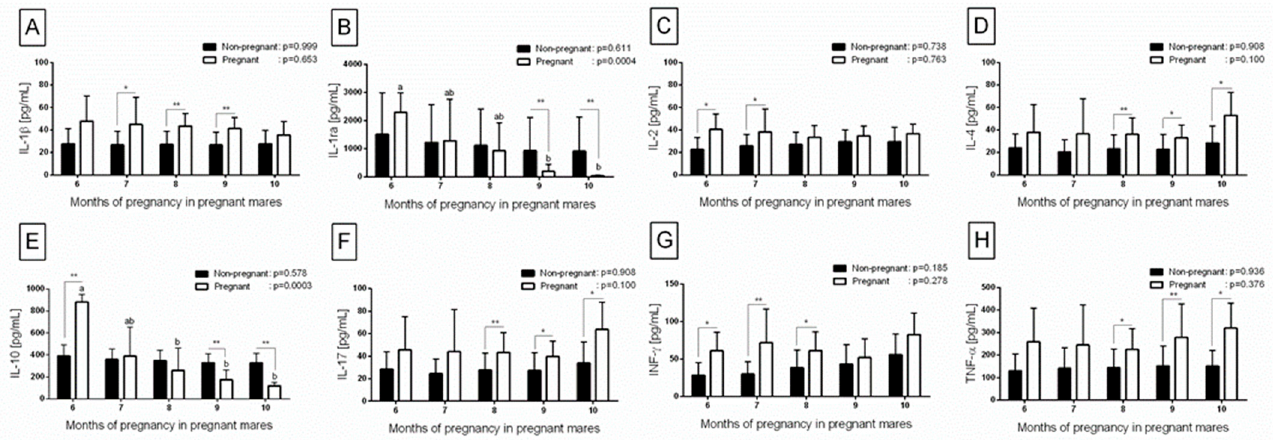
Figure 2. The concentration (mean + SD) of ( A ) interleukin 1ß (IL-1ß), ( B ) interleukin 1ra (IL-1ra), ( C ) interleukin 2 (IL-2), ( D ) interleukin 4 (IL-4), ( E ) interleukin 10 (IL-10), ( F ) interleukin 17 (IL-17), ( G ) interferon γ (INF- γ ), and ( H ) tumor necrosis factor α (TNF- α ) in the mares’ blood representing six groups—the non-pregnant mares and five sub-subgroups of pregnant mares representing the 6th, 7th, 8th, 9th, and 10th months of pregnancy. Different letters indicate differences between non-pregnant and pregnant groups only when p < 0.05. The asterisk indicates differences between the non-pregnant and pregnant mares (* p < 0.05; ** p < 0.01).